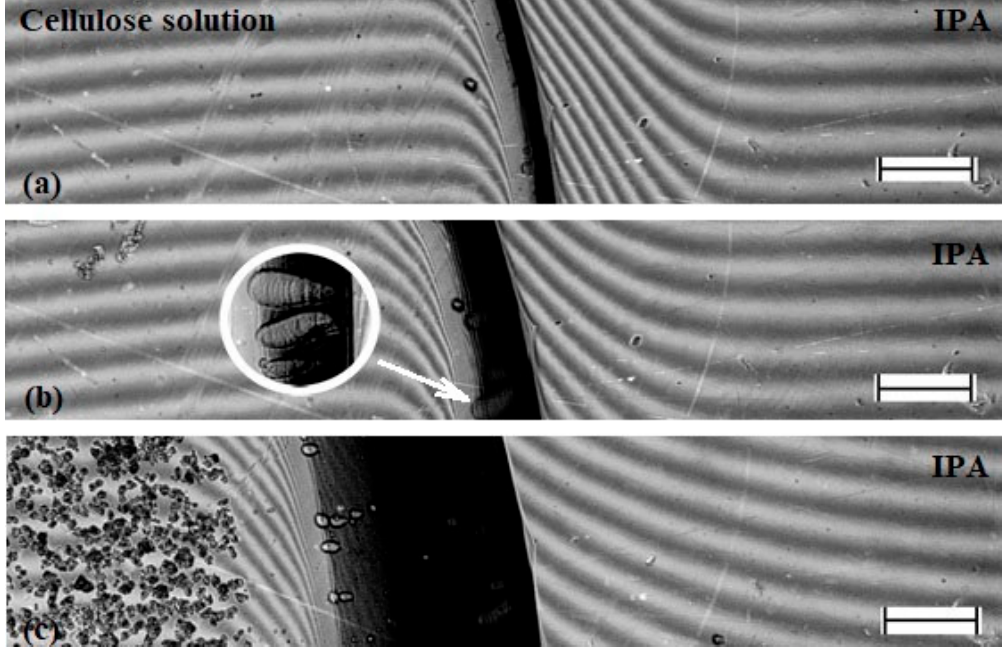
Figure 9. Interferograms of the contact zone of cellulose solution in NMMO and IPA during “cold” coagulation. The time of the experiment: ( a ) 1 min; ( b ) 5 min; and ( c ) 1 h. The length of the scale bar is 250 µ